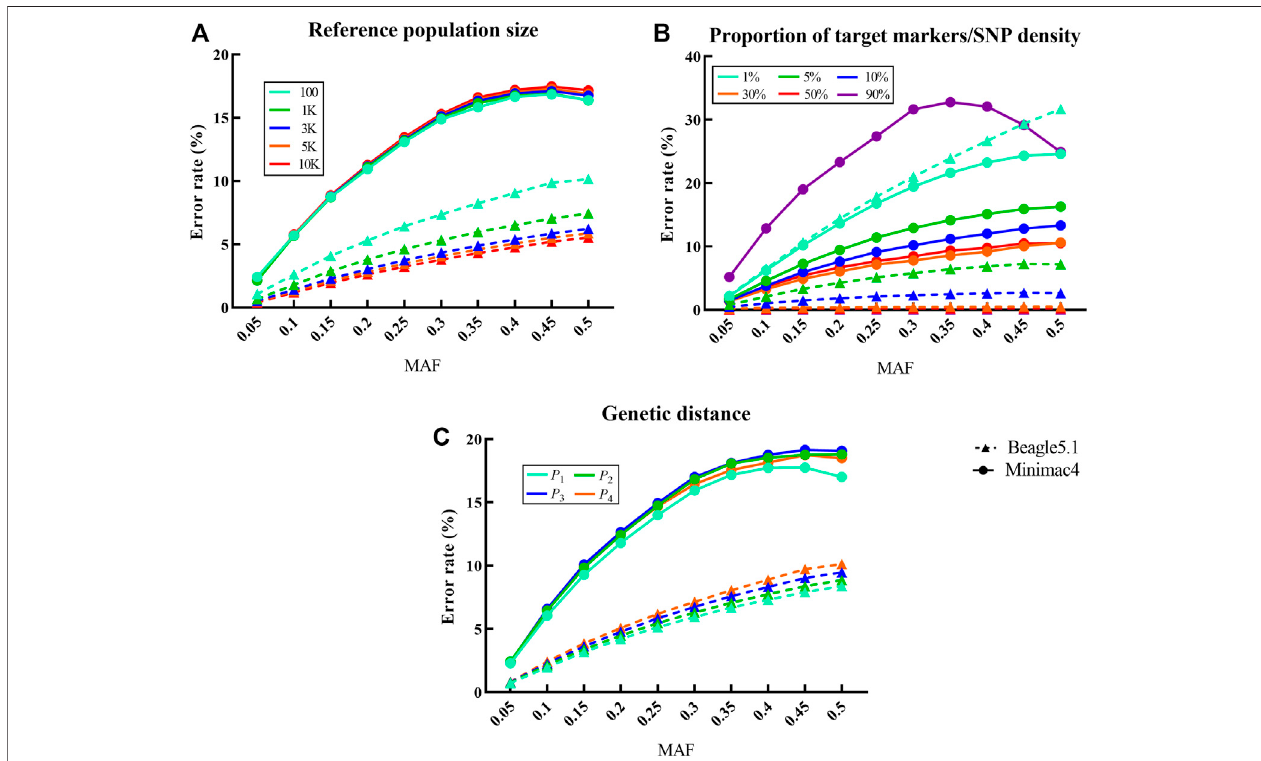
FIGURE 3 | In fl uence of different factors on the imputation error rate in LCWGS data. For each fi xed level of the factors under each scenarios, the average at different levels of all other factors is taken as the error rate. Imputed alleles are binned according to their MAF count in each scenarios. Dotted line with a triangle sign represents Beagle5.1, while the solid line with a round sign represents Minimac4. Different colored signs represent different levels. (A) In fl uence of reference population sizeontheimputationerrorrate. (B) In fl uenceofproportionoftargetmarkersorSNPdensityontheimputationerrorrate. (C) In fl uenceofgeneticdistancebetween reference population and target population on the imputation error rate.